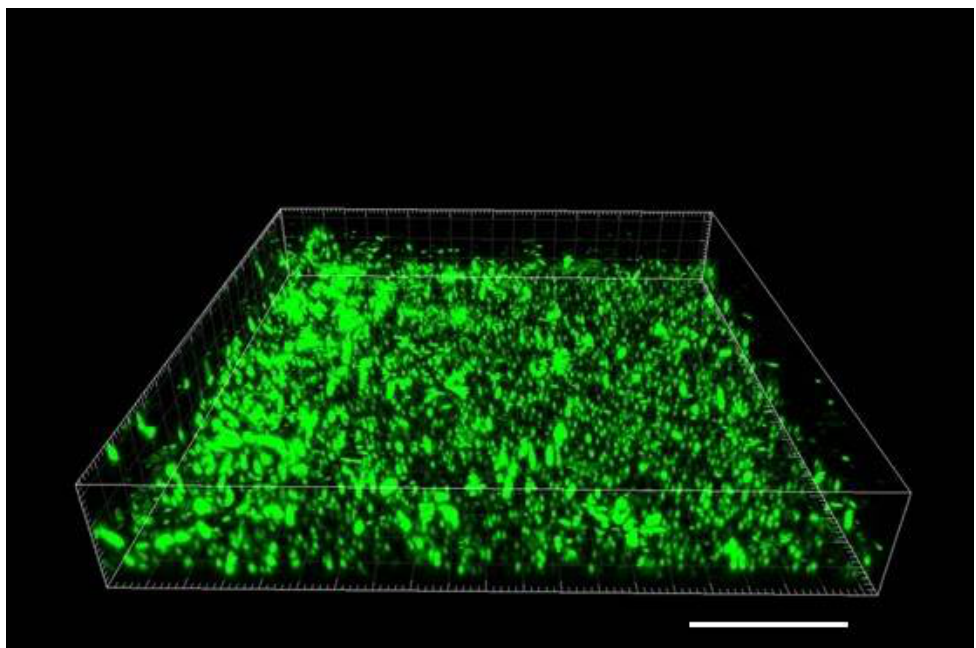
Figure 4. Three-dimensional rendering of a group of E. coli cells located on the top of biofilm in a channel of Ibidi cell. Side of the square frame 101.6 μm; height (z-dimension) 17.0 μm; scale bar applies to the front lower edge = 20 μm. Only the data of green fluorescence band (Syto 9; excitation 488 nm) were used to allow better resolution of E. coli rod-shaped cells. These cells appear larger than S. epidermidis cocci in the biofilm due to their higher brightness and slight shift during scan.